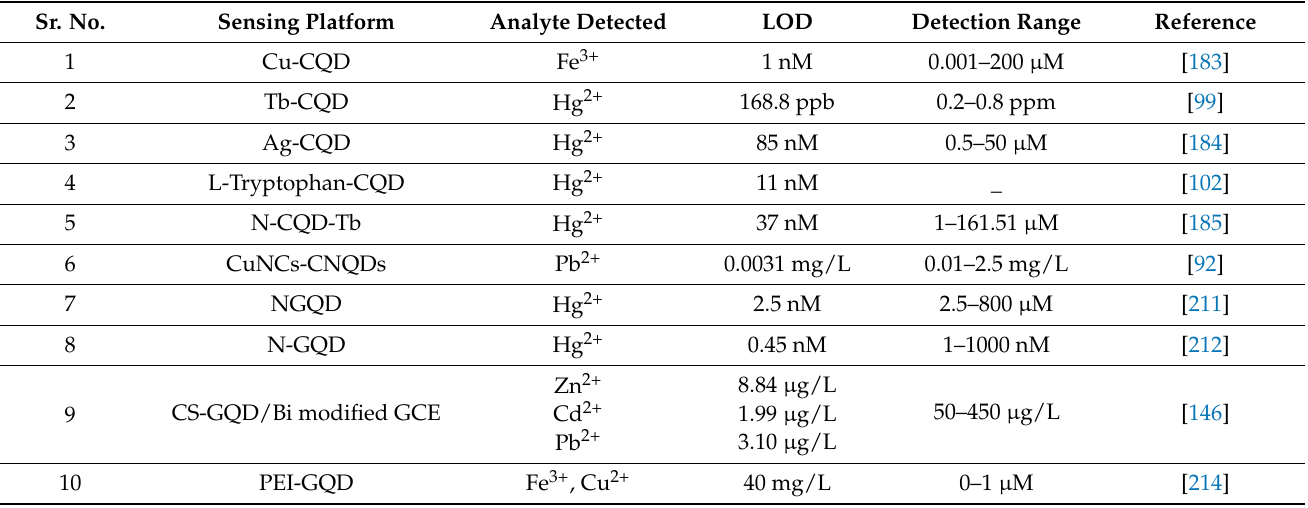
Table 1. Sensing behavior of CQDs and GQDs for detection of heavy metal ions.